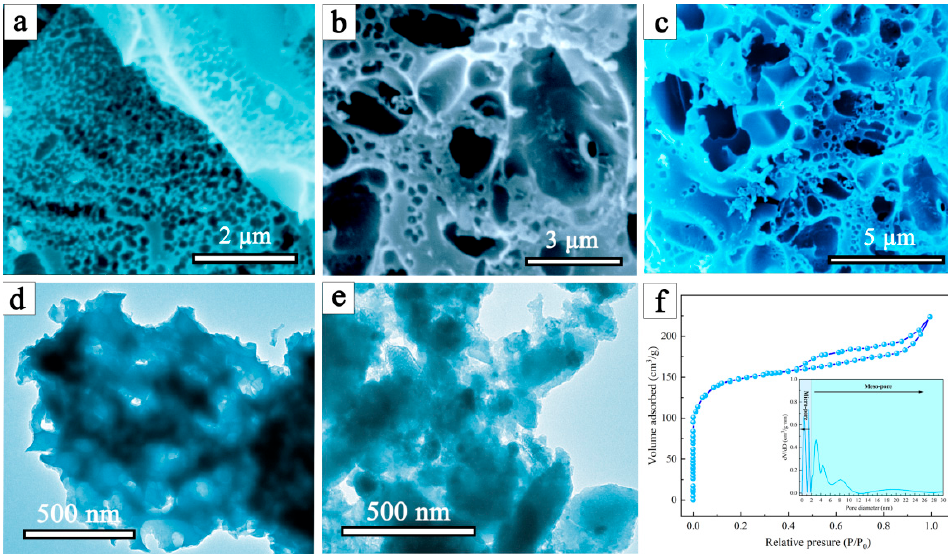
Figure 2. ( a – c ) SEM images of DMAL, ( d ) TEM image of alkaline lignin carbon, ( e ) TEM image of DMAL, and ( f ) nitrogen adsorption-desorption isotherms of the DMAL carbon material, inset shows the pore size distribution of DMAL.